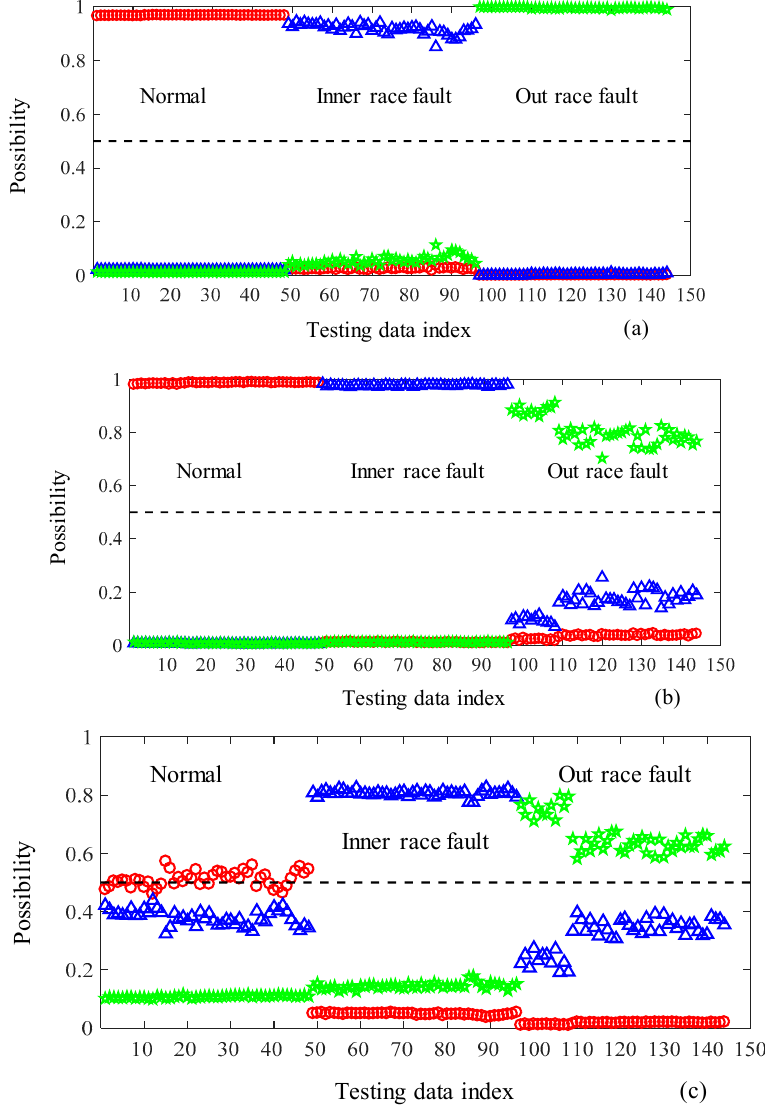
Figure 10. Classification results of the Resnet classifier: ( a ) the training and testing datasets are the real original data; ( b ) the training and testing datasets are the real envelop data; ( c ) the training dataset is the simulation data while the testing dataset is the real data.